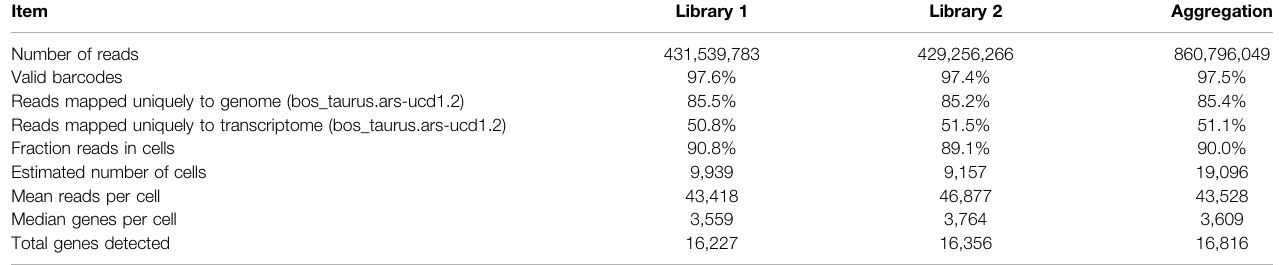
TABLE 1 | Summary of scRNA-seq sequencing, mapping, and analysis.